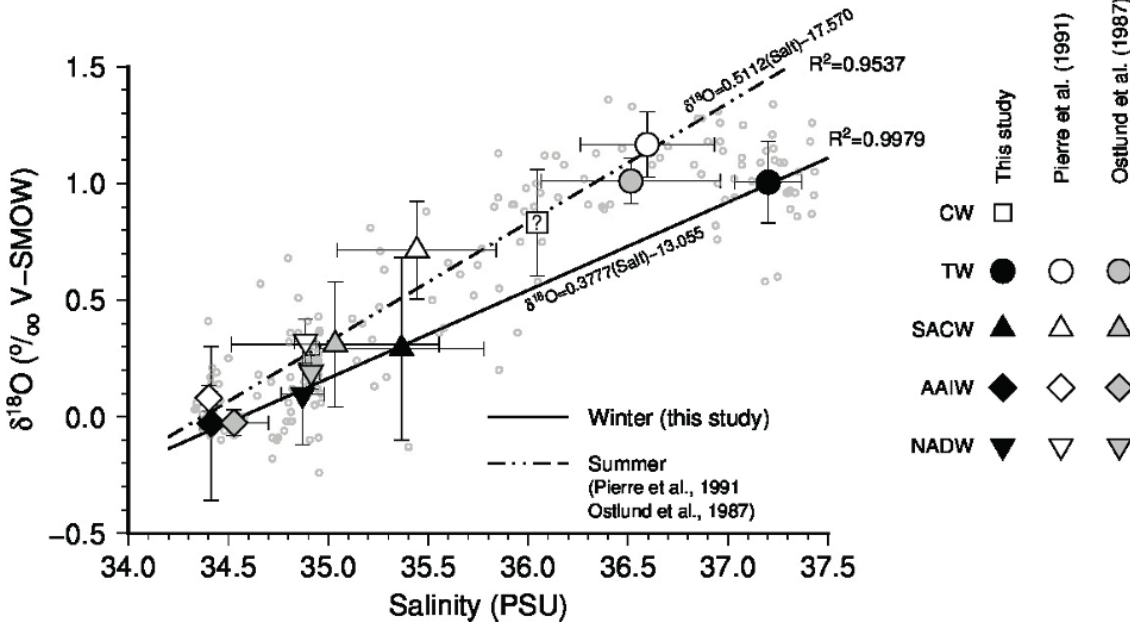
content for each water mass in the previous study in the Southwestern Figure 5 - Means and standard deviation of salinity and δ 18 O sw Atlantic Ocean – Pierre et al. (1991) (white symbols) and Ostlund et al. (1987) (grey symbols) and the present study (black symbols). the solid line represents the Winter Mixed Line and the dashed line represents the Summer Mixed Line. the raw data are presented as small grey